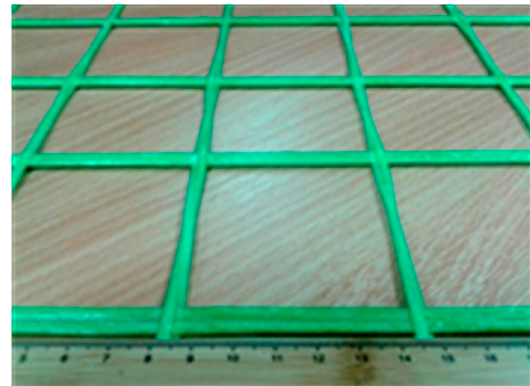
Figure 1. Glass-fiber-reinforced polymer (GFRP) grid with a 66 × 66 mm mesh size.